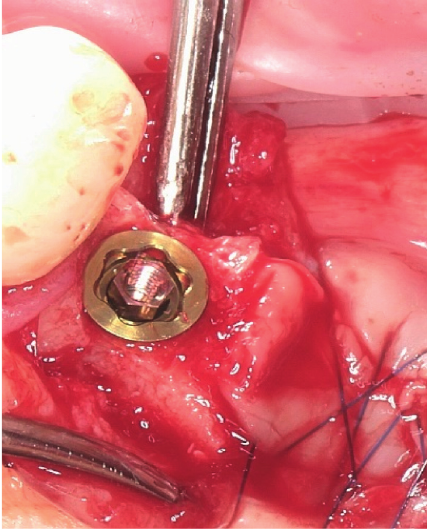
Figure 7: Placement of the removable On1 base into the